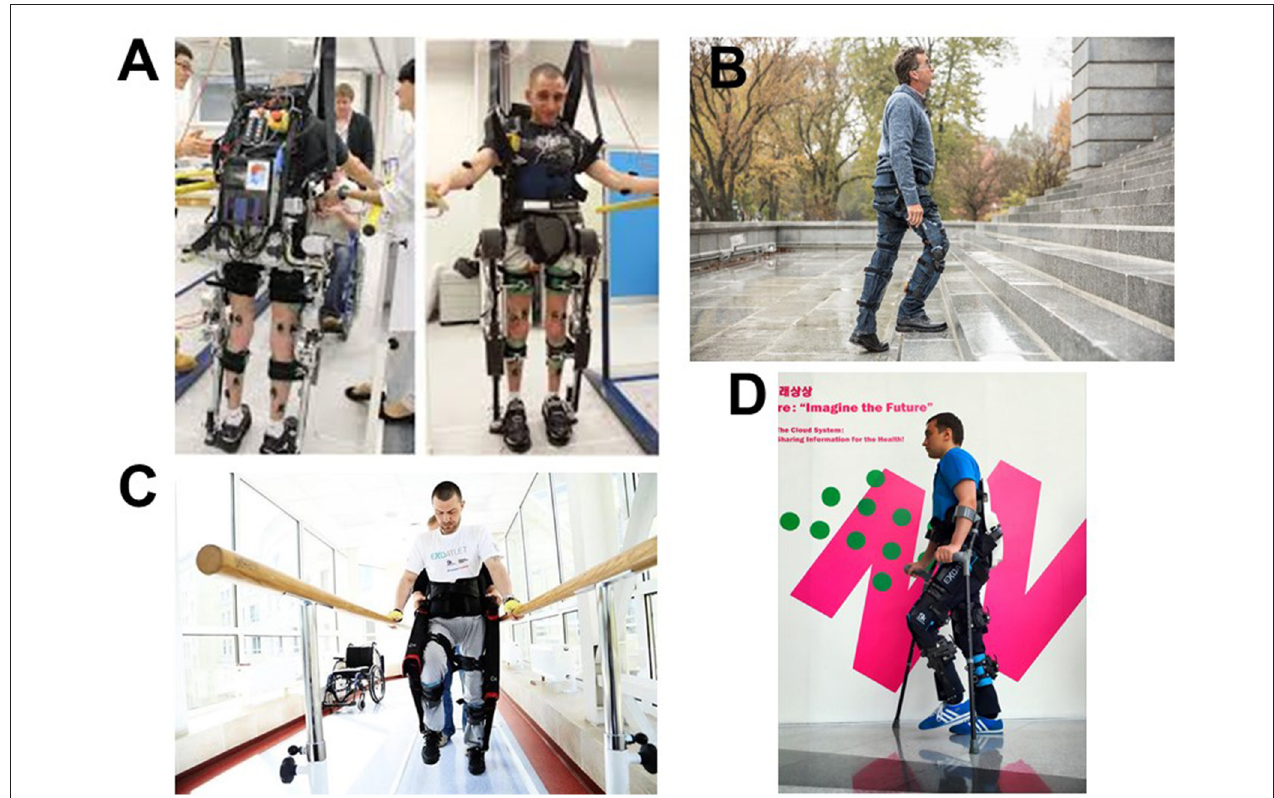
FIGURE 2 | Images of several types of exoskeletons. (A) Mindwalker mind-controlled exoskeleton could help the disabled walk again. With courtesy from Professor van der Kooij at University of Twente, NL. (B) The Keeogo TM exoskeleton from B- TEMIA reveals the latest in an increase of the human systems (human augmentation systems) designed to help people walk more and better. Keeogo TM eliminates several problems in patients with Parkinson’s disease. With courtesy from Danielle Beaudoin at b-termia.com. (C,D) The ExoAtlet is a powered exoskeleton designed to assist patients during their rehabilitation after stroke, injury, or unsuccessful operation. ExoAtlet automatically repeats the natural patterns of walking, has electrical stimulation system, and physiological sensors. The control system of the ExoAtlet is unique: it collects data from body angles, allows to set the height and length of the step, which provides: (i) standing still; (ii) classic walking; (iii) walking on angled surface; (iv) stepping over obstacles; and (v) comfortable walking up & down stairs. ExoAtlet can be used in rehabilitation centers and at home 24 . ExoAtlet can be controlled with the app on tablet when used in clinics. Experienced user of ExoAtlet use “thinking” crutch for control. With courtesy from Ekaterina Bereziy at